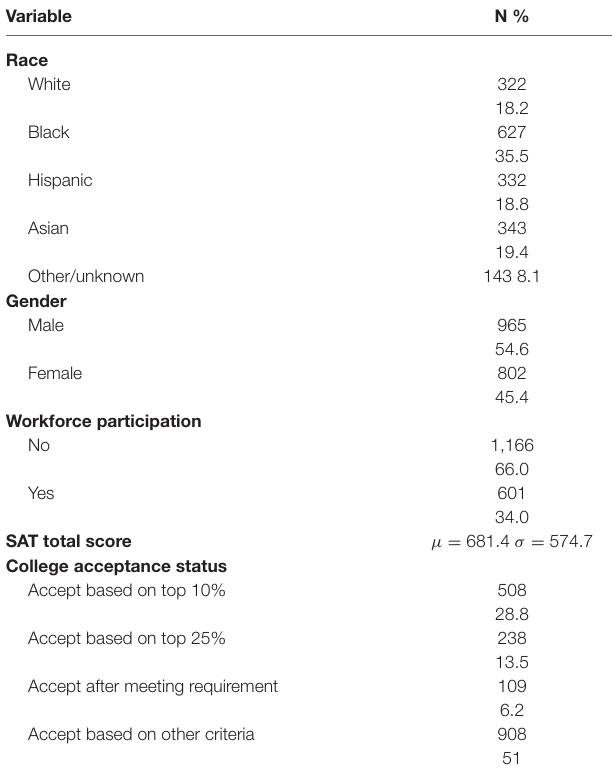
TABLE 1 | Descriptive statistics–H-LSAMP